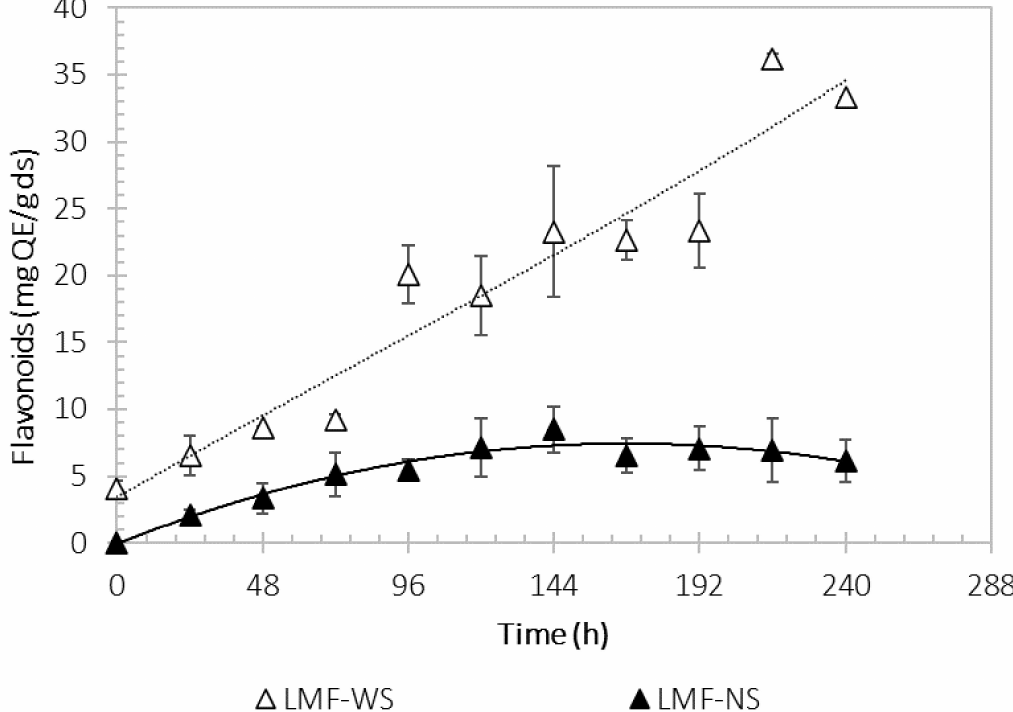
Figure 4. Kinetics of flavonoid production by Aspergillus niger M4 in a liquid fermentation process, using washed Sargassum (light color) and natural Sargassum (solid color) as